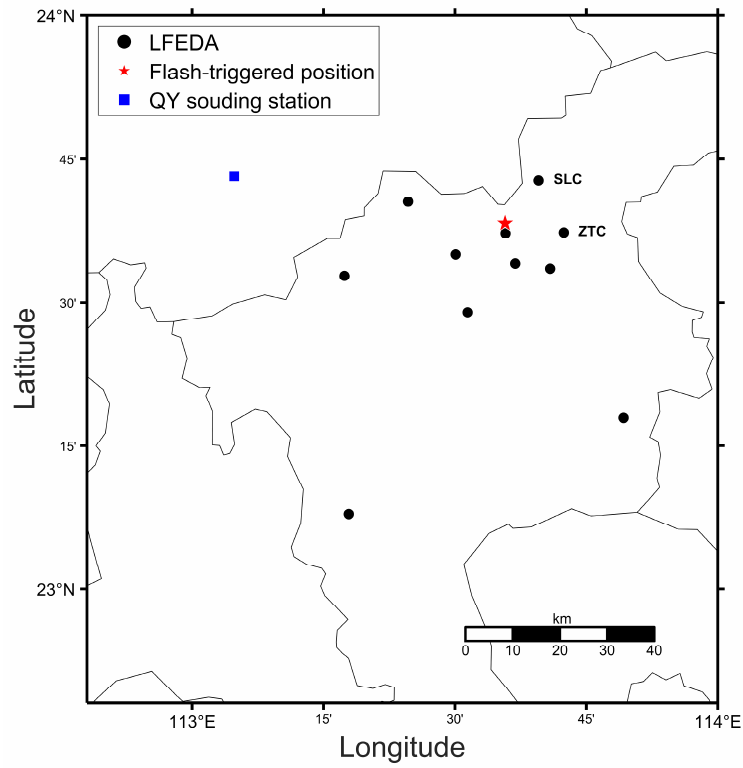
Figure 2. Spatial distributions of the main observation systems in Guangdong, China. The atmospheric average electric field (AAEF) meter is located at the flash-triggered position.